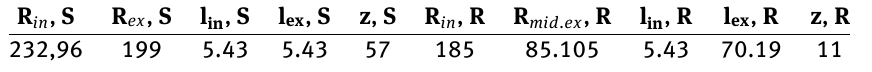
in the entire flow domain does not exceed 2. The flow patterns do not exhibit shock